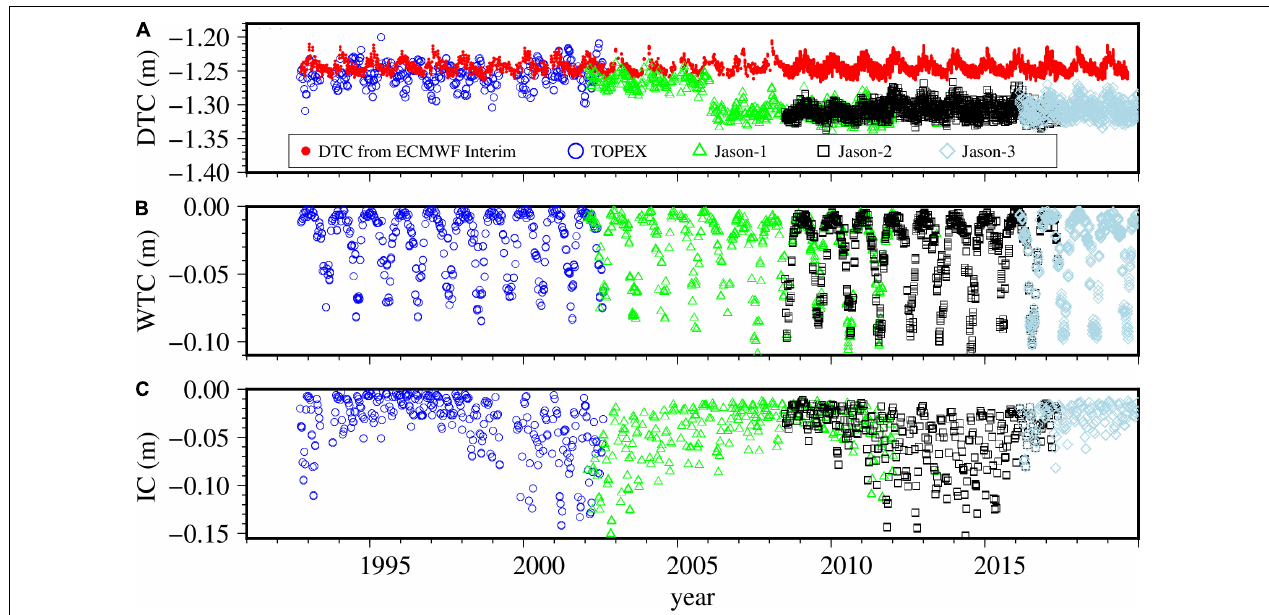
FIGURE 3 | Atmospheric path delay correction of T/P-Jason1/2/3. (A) Dry troposphere correction (DTC). (B) Wet troposphere correction (WTC). (C) Ionosphere correction (IC).